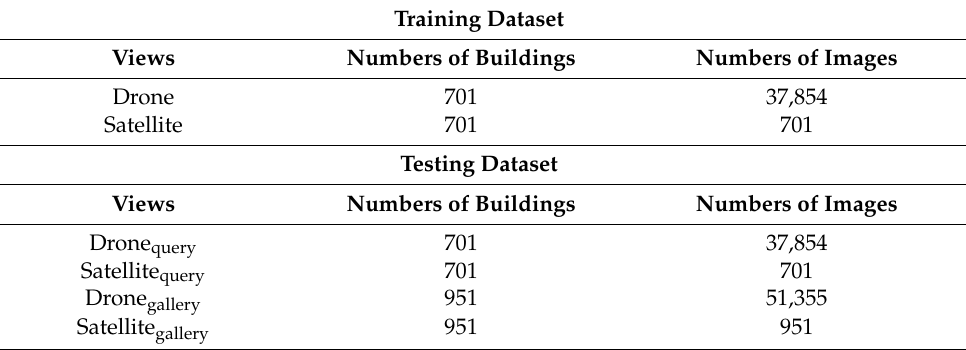
Table 1. Statistics experimental data. Including the image number of query set and gallery set for different geolocalization